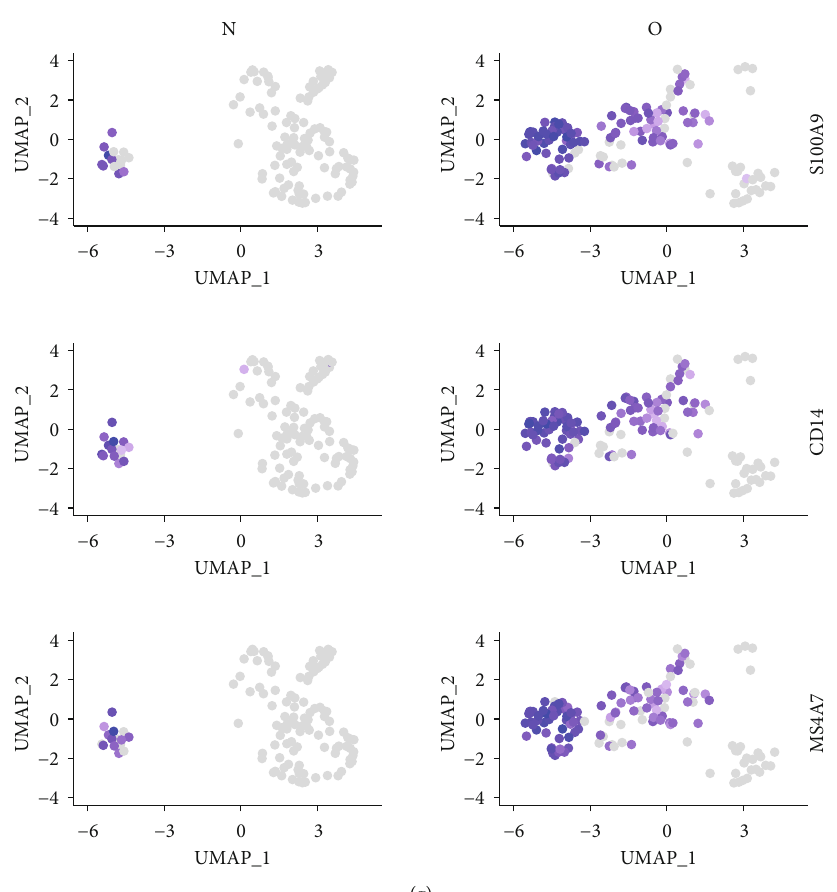
Figure 2: Single-cell RNA-seq analysis of nonchondrocytes from healthy and OA patients. (a) UMAP plot of 259 single cells from the human knee depicting 3 nonchondrocyte cell types. (b) Bar plot shows frequency of each cell type in the healthy and OA groups. (c) Split UMAP plot depicting the nonchondrocyte clusters from healthy (N) and OA patients (O). (d) Heat map indicates the top 10 marker genes for each cell type. (e) Expression distribution of the top marker genes for the nonchondrocytes projected onto the UMAP plot. (f) Expression distribution of top markers in the monocyte cluster. (g) Expression distribution of top markers in the macrophage